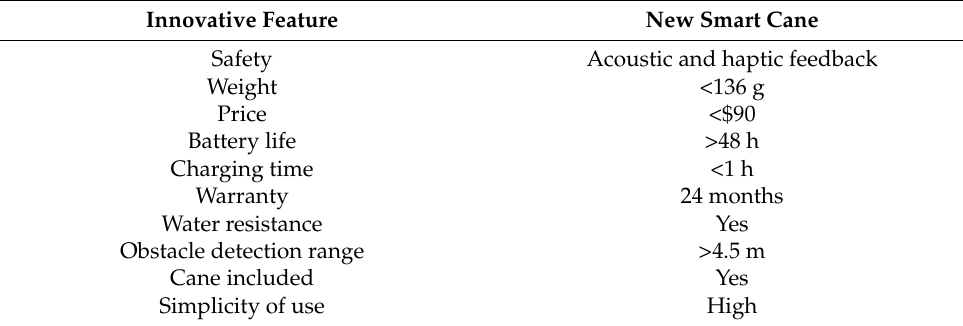
Table 8. Innovative features